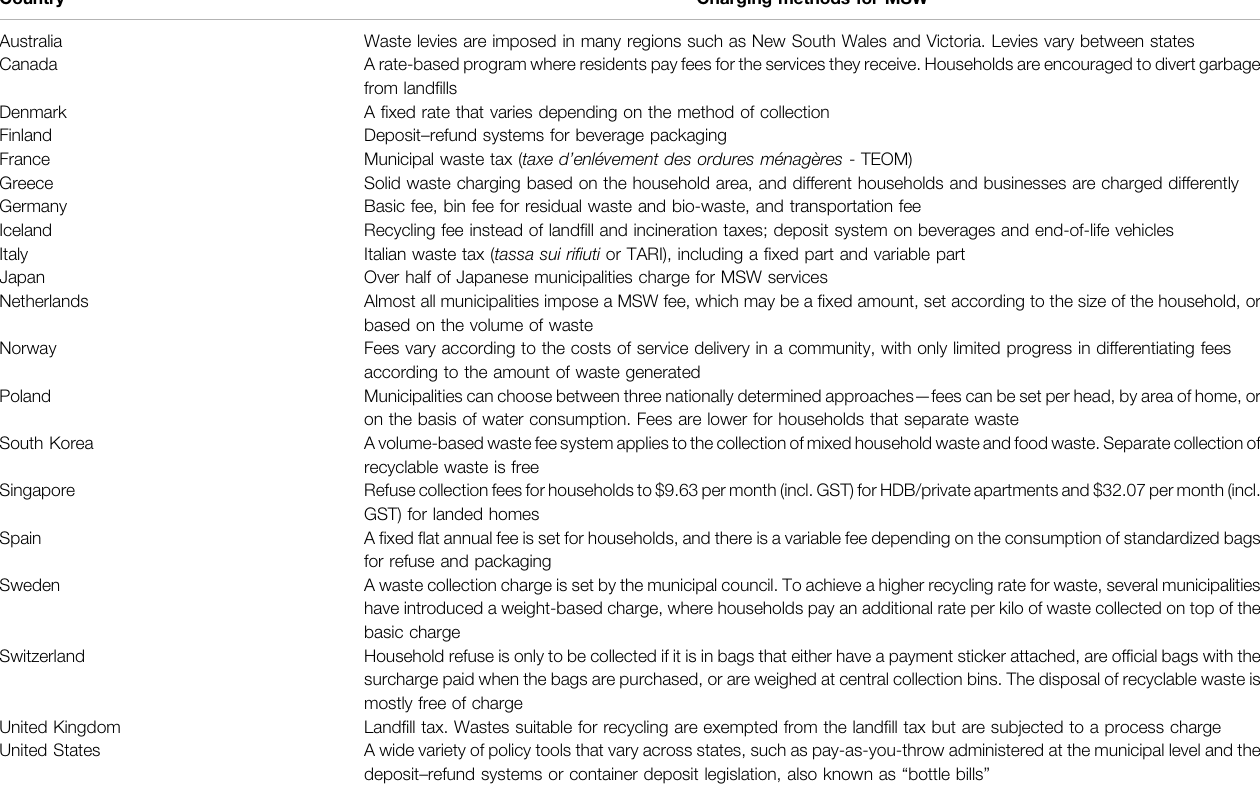
TABLE 1 | Waste charging methods by countries. Country Charging methods for MSW